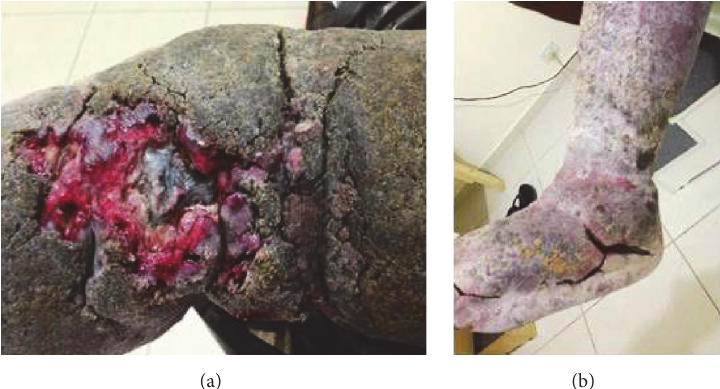
Figure 3: Plaque with a thickness of 0.5 to 1cm thick which was eliminated with treatment.